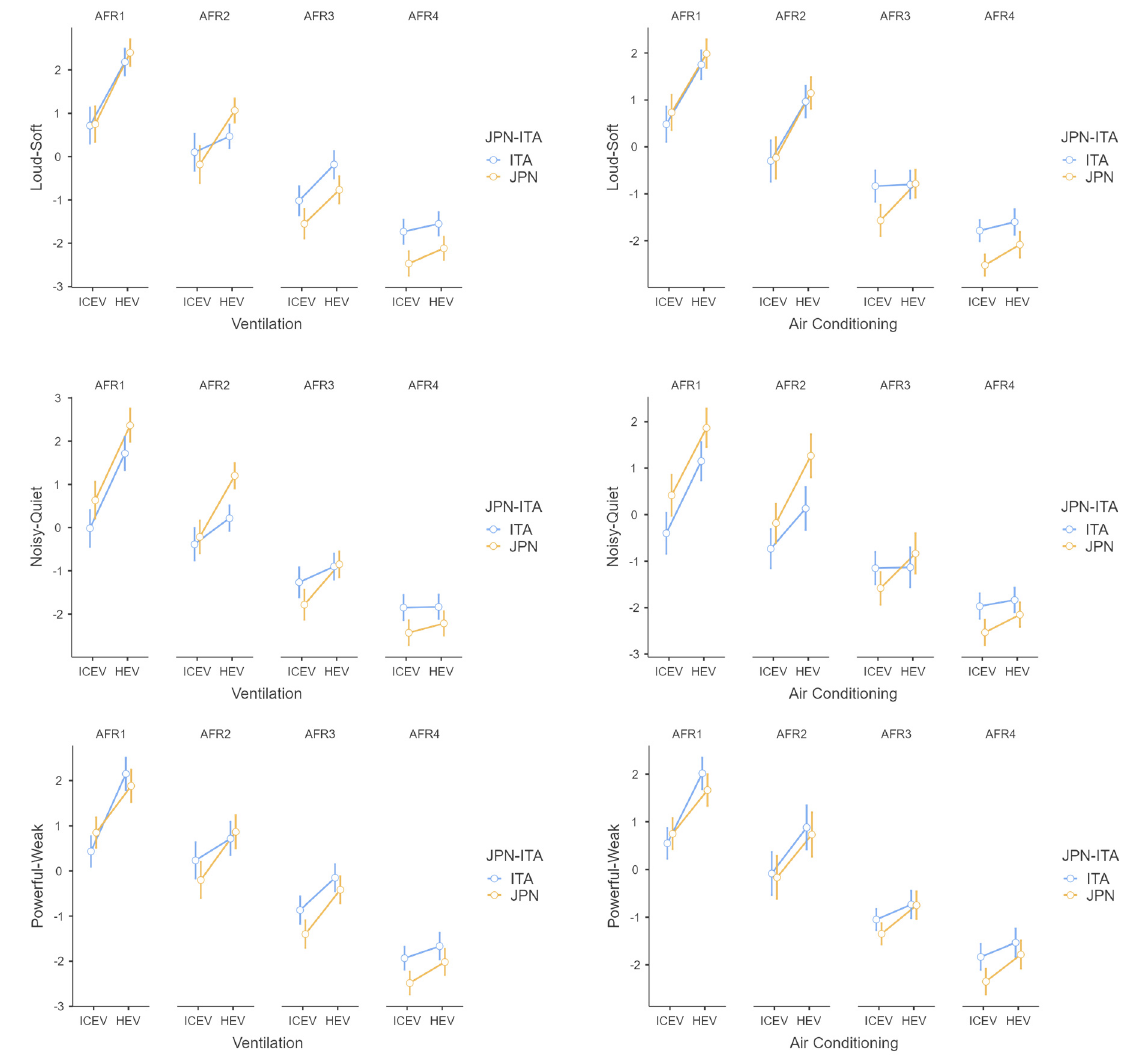
Figure 2. Marginal mean and 95% confidence interval of the Loudness dimension items in the Ventilation ( left ) and Air Conditioning ( right ) Functional Modality, for different AFR, Engine Type, and Subject Group.